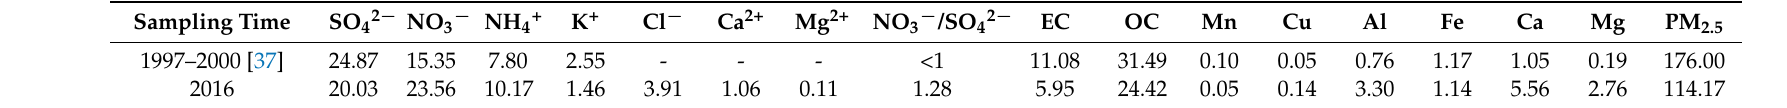
Table 3. Interannual variation of concentration of PM 2.5 and its major chemical compositions.